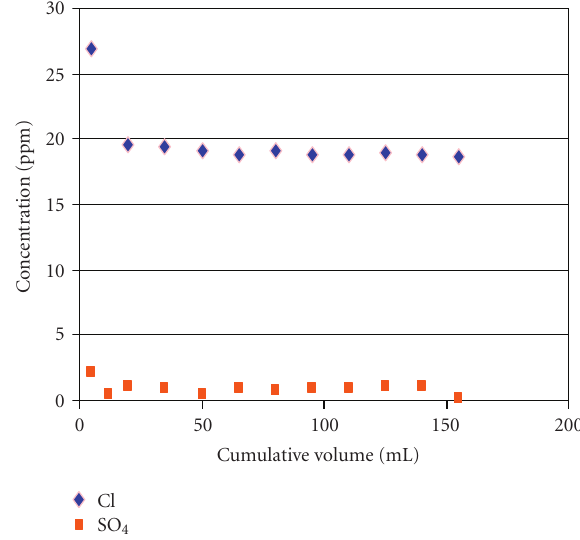
Figure 12: Breakthrough results for prepared ion exchanger using 50 ppm Cl and 10 ppm SO 4